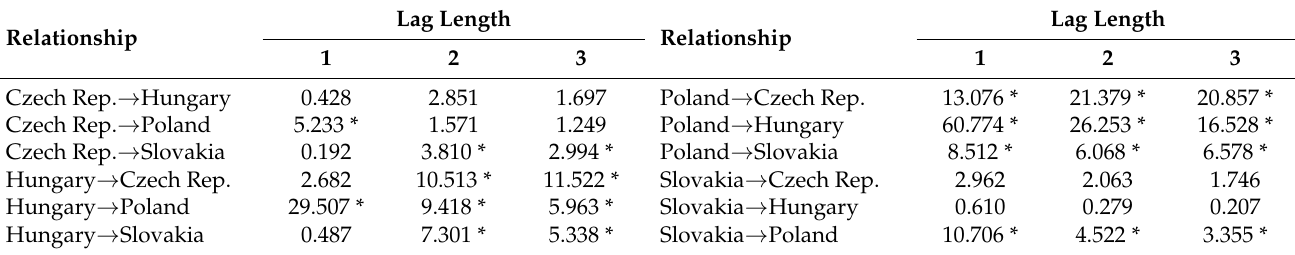
Table 7. Granger causality test results for Pb95 gasoline.